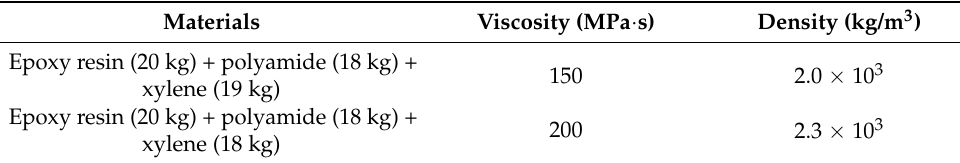
Table 3. Material parameters of the adhesive layer.